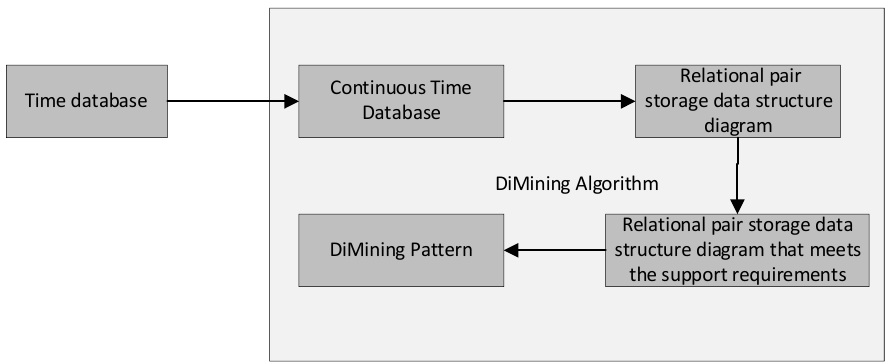
Figure 7. DiMining Algorithm framework diagram.